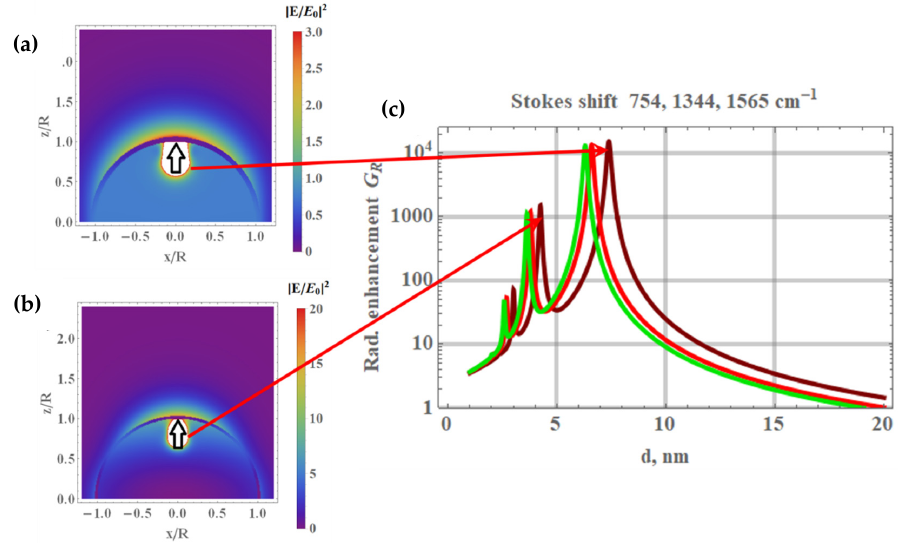
Figure 9. Radiation enhancement G R of the Raman signal from the aggregate of molecules of RBD protein coated with a spherical silver envelope with a radius of R = 90 nm as a function of silver layer thickness d. ( a , b ) The electric field distribution in the dipole and quadrupole resonances excited by the molecular dipole, which is indicated with an open arrow; the dipole oscillates with a frequency of 2 π c /( λ = 834 nm), which corresponds to the Trp Stokes shift (754 cm − 1 ) from the funda- mental laser frequency of 2 π c /( λ = 785 nm); ( a ) the dipole resonance is excited in the silver envelop with a thickness of d = 8 nm; ( b ) the quadrupole resonance is excited at d = 4 nm; ( c ) radiation en- hancement G R ( d ); molecular dipoles are distributed over the internal surface of the silver envelope with a radius of R = 90 nm; the thickness of the dipole layer is 8 nm; the dipoles radiate at wave- lengths of λ = 834, 878, and 895 nm (the brown, red, and green curves), which correspond to the main Stokes shifts (754, 1344, and 1565 cm − 1 ) in the Raman signal from the RBD protein (cf. Figures 6 and 7); the Raman signal from the plasmon resonator is normalized to the Raman signal generated by the bare molecular layer.